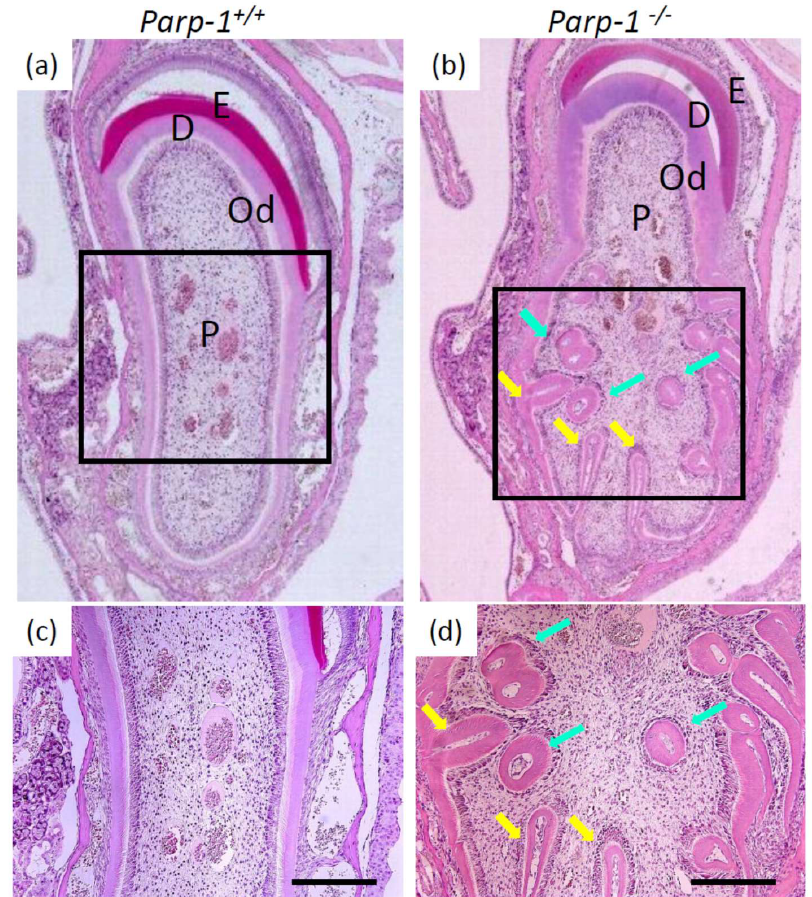
Figure 1. Histopathological analysis of incisors of aged Parp-1 +/+ and Parp-1 −/− mice (ICR/129Sv). ( a ) hematoxylin and eosin staining (HE) staining of coronal plane of Parp-1 +/+ incisor. ( b ) HE staining of coronal plane of Parp-1 −/− incisor. ( c ) and ( d ) are a higher magnification of the black box of (a) and (b), respectively. Light blue arrows indicate denticle structure and yellow arrows indicate dental dysplasia. E = enamel, D = dentin, Od = odontoblast, P = pulp. Bars indicate 200 µm. Table 1. Incidence of dental dysplasia of aged ICR/129Sv mice.